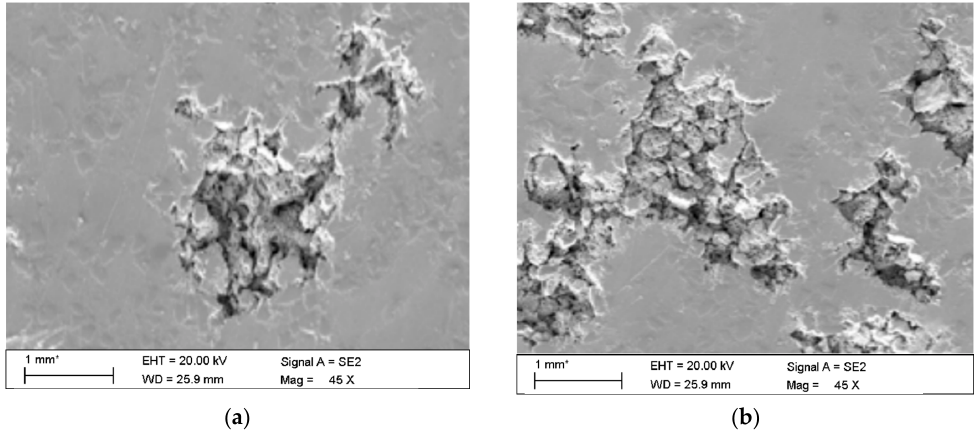
Figure 16. Surface of tested aluminium alloy after 7 ( a ) and 14 ( b ) days in demineralised water. Visible changes in form of pits.